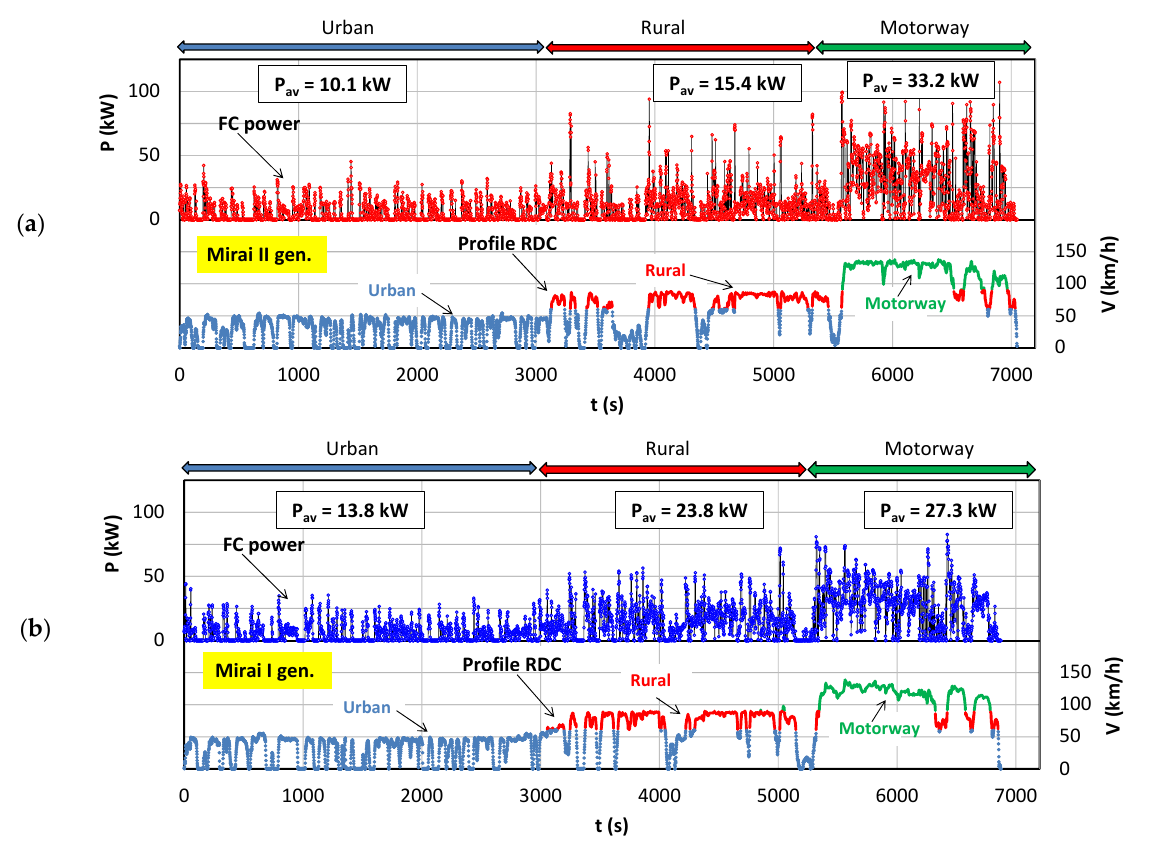
Figure 13. Fuel cell stack power and speed profiles in the RDC test: ( a ) I generation HFCHEV drive; ( b ) II generation FCHEV drive.